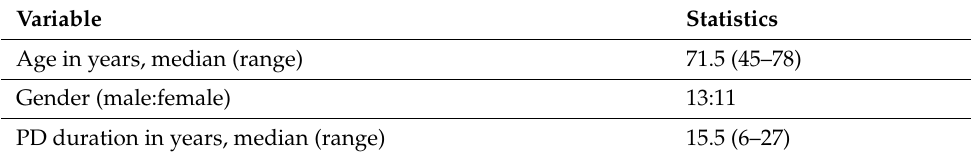
Table 1. Demographics based on data collected from medical records ( n = 24).